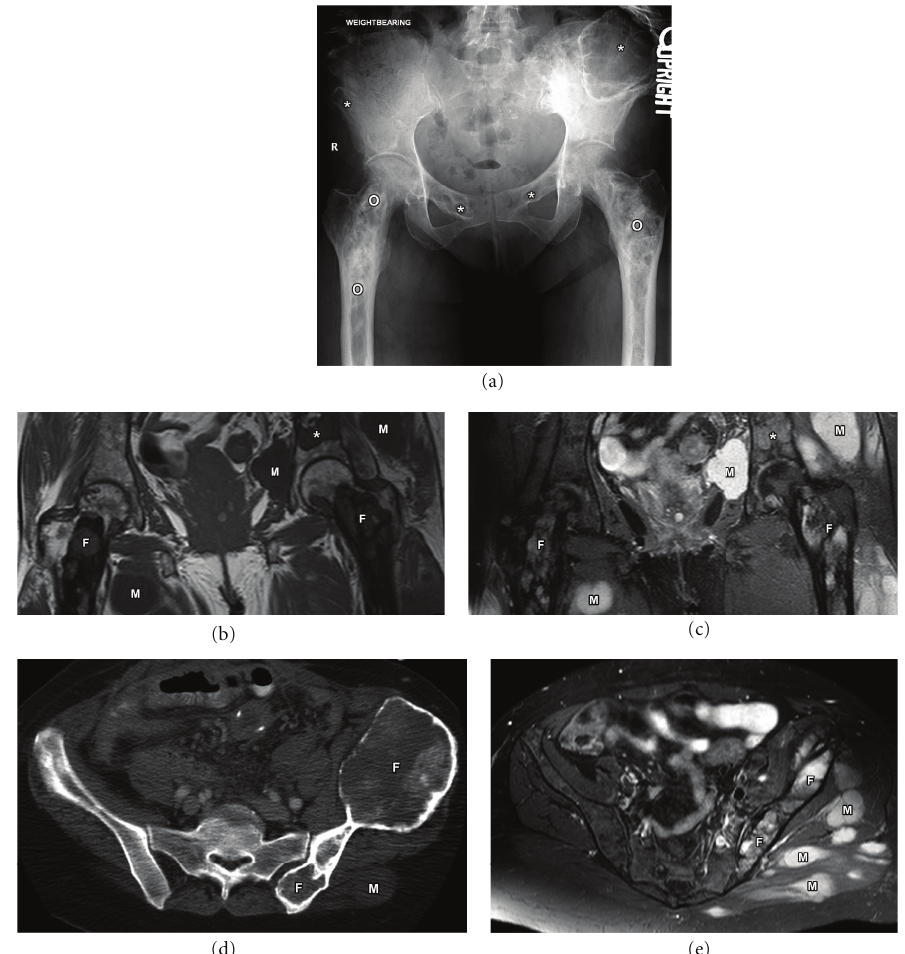
Figure 5: 61-year-old female with Mazabraud syndrome (polyostotic fibrous dysplasia and soft tissue myxomas (M)). Plain film (a) demonstrates multiple lucent lesions with ground glass matrix in the pelvis (asterisk) and long predominantly sclerotic abnormality in bilateral femurs (circle). Fibrous dysplasia is often described as a long lesion in the long bone. Coronal T1 (b) and STIR (c) MRI images demonstrating multiple fibrous dysplasia (F) lesions. Note that some of these maintain low to intermediate signal intensity on both T1 and T2 images (asterisk). Axial CT (d) and axial T2 fat sat (e) MRI images demonstrating contour abnormality of the left ilium with ground glass matrix and focal bone expansion (F). Multiple T2 bright myxomas (M) are noted in the gluteal